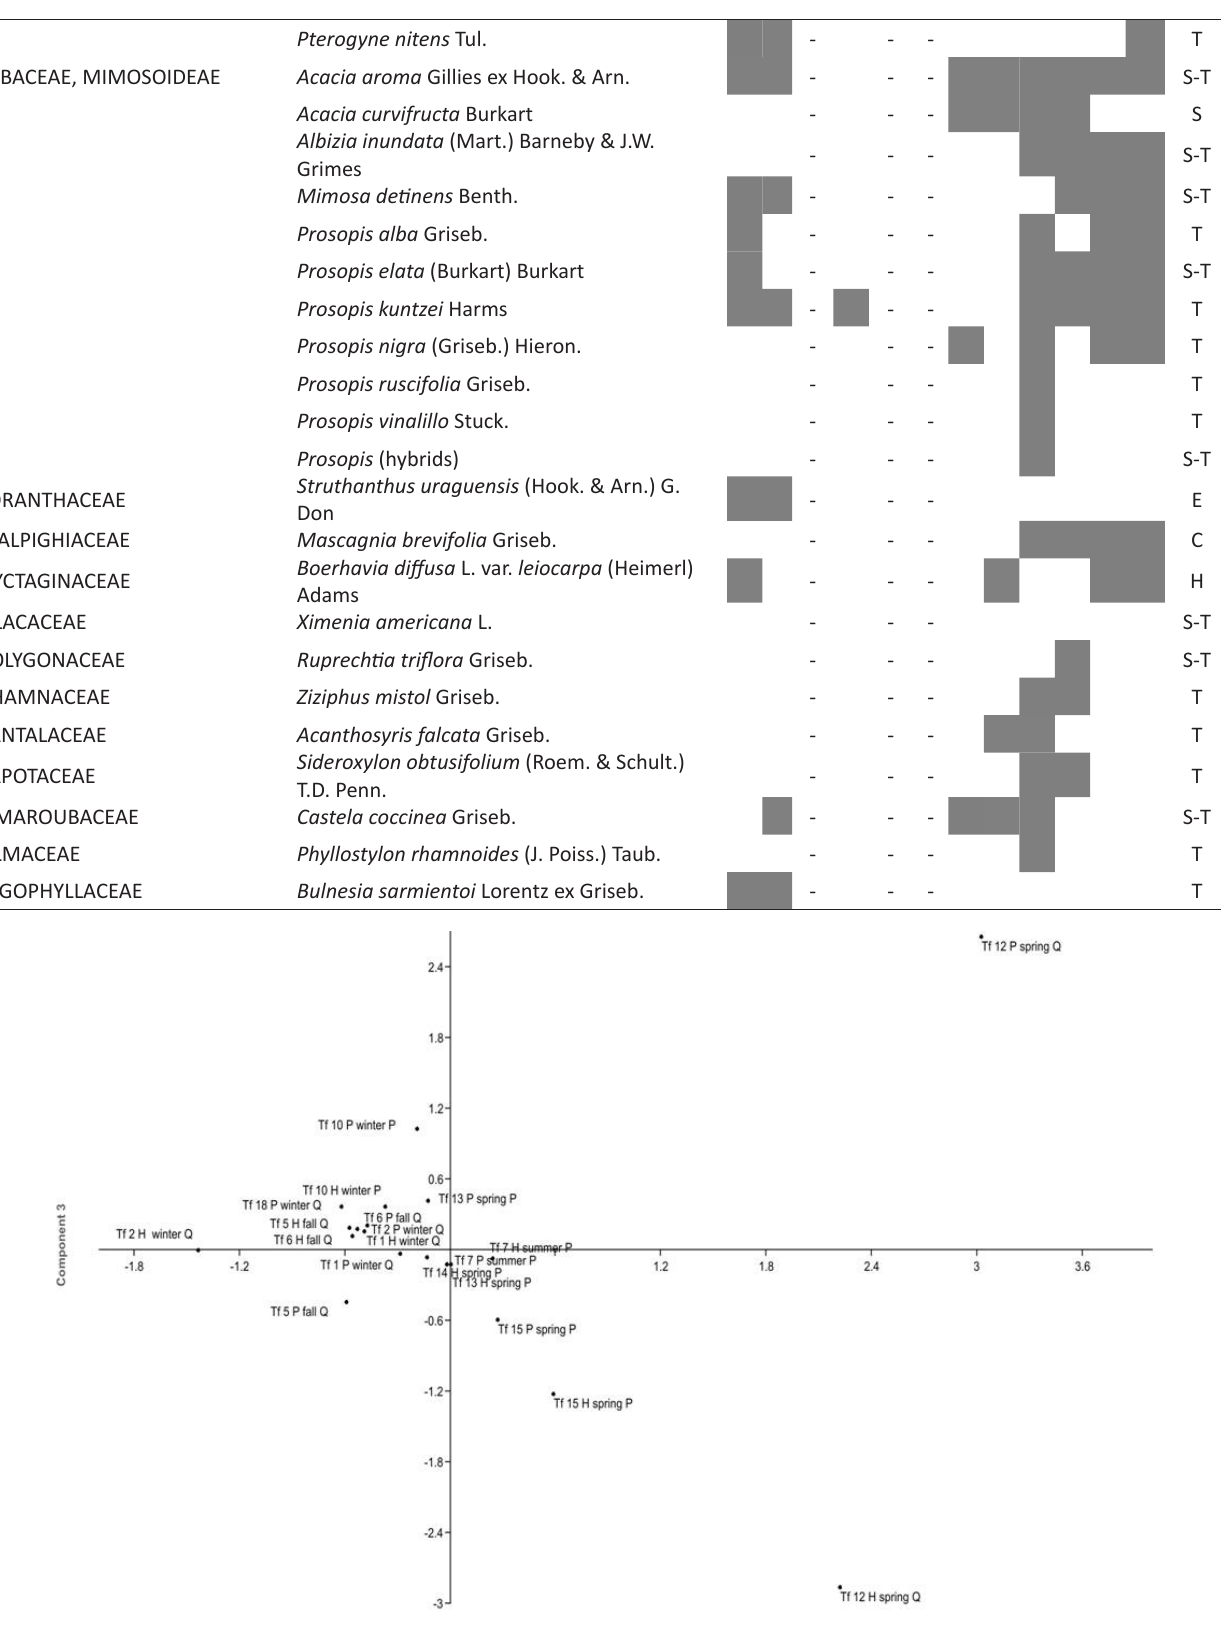
Table 3 . Flowering phenology of the plant taxa whose ascribed pollen types were found in the stores of Tetragonisca fiebrigi in the Dry Chaco forest. During March, May and June, flowering was not recorded. Plant life-forms: T = trees, S = shrubs (more than 1 m in height), C = climbers and lianas, H = herbs, semi-shrubs and shrubs less than 1 m in height, E = epiphytes. (Continuation).